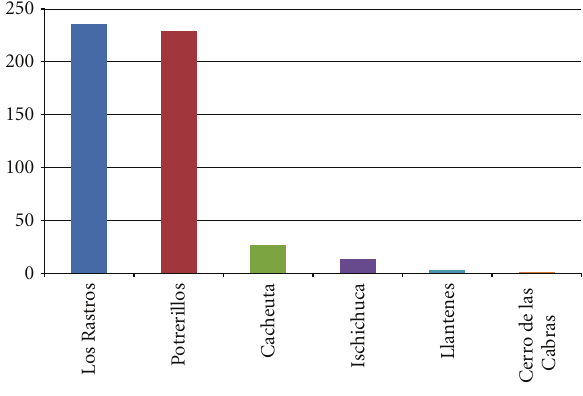
Figure 3: Bar graphic showing the abundance of specimens in di ff erent Triassic insect localities. (Note: included new undescribed